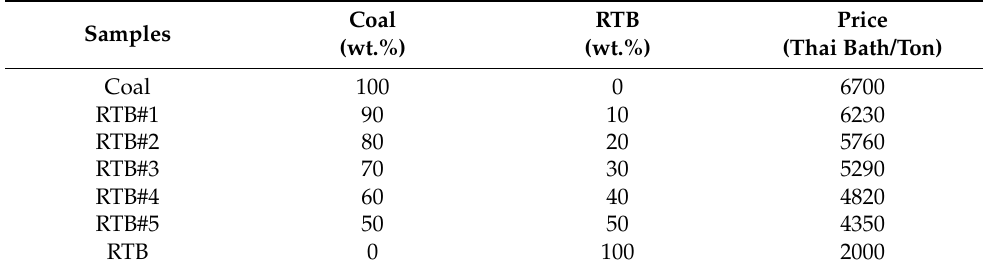
Table 11. Estimate price of the samples used in this